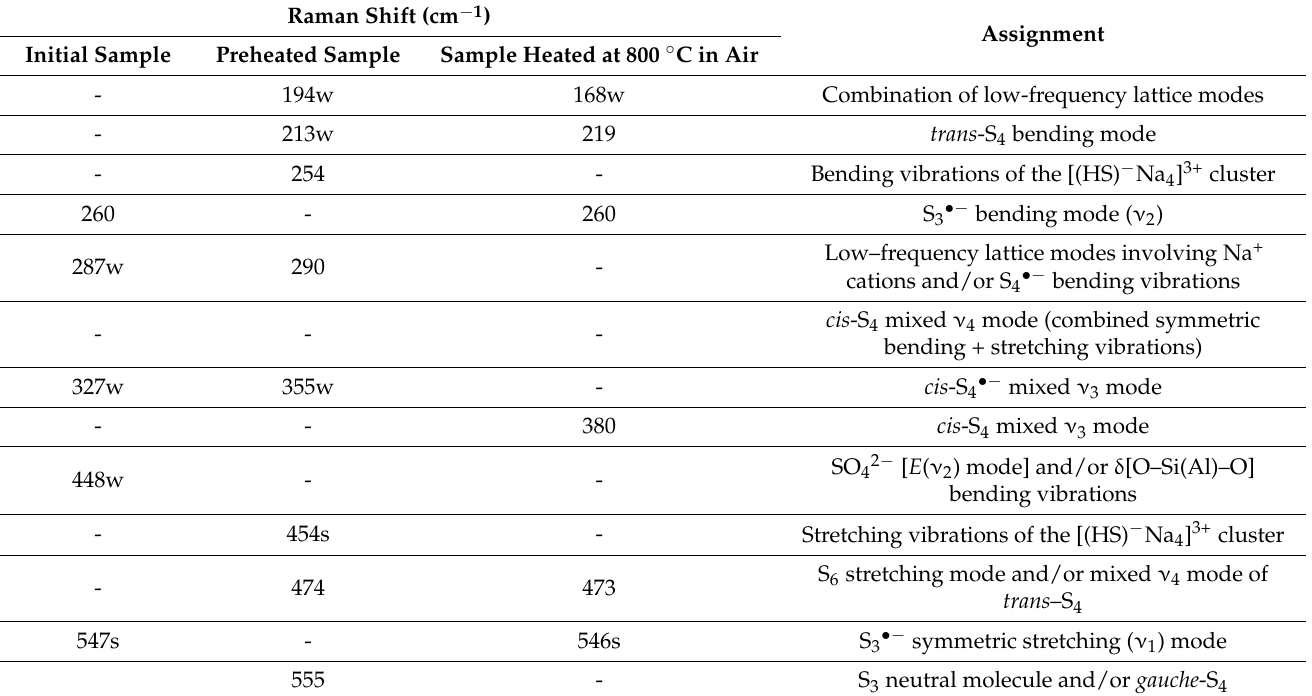
Figure 10. Raman spectra of ( a ) initial haüyne (Sample 5), ( b ) Sample 5 preheated for three days at 700 ◦ C, over the Fe-FeS buffer, and ( c ) preheated Sample 5 additionally annealed at 800 ◦ C in air for one day. Table 3. Assignment of Raman bands of Sample 2 and products of its thermal